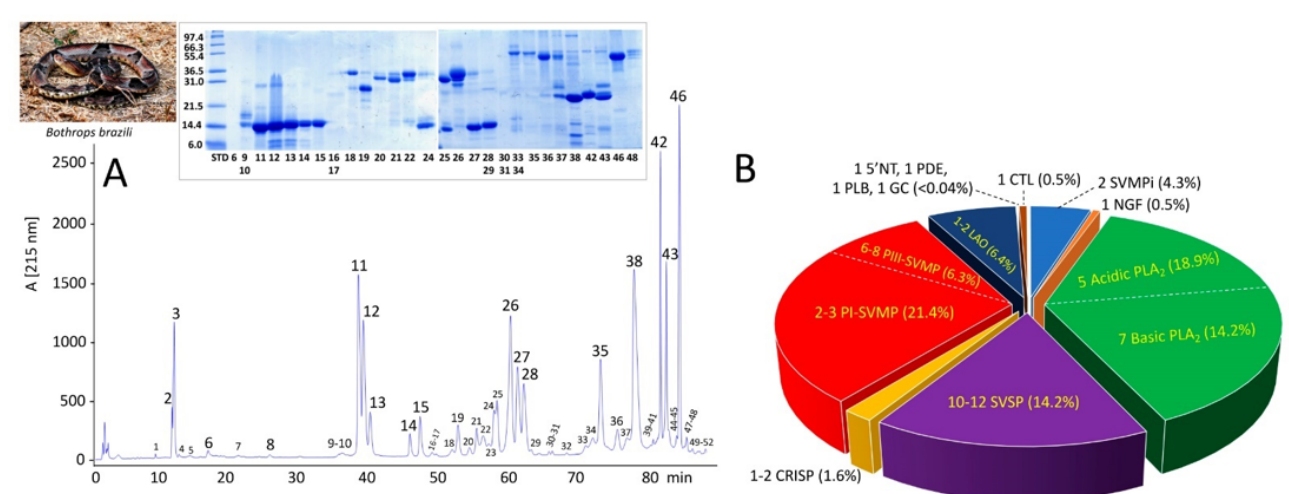
Figure 1. Venomics analysis of Bothrops brazili. (A) Reverse-phase chromatographic separation of the venom proteins of Bothrops brazili from Pará, Brazil. For venomics analysis the chromatographic fractions were collected manually and analyzed by SDS-PAGE (inset) under reduced conditions. Protein bands were excised, in-gel digested with trypsin, the resulting proteolytic peptides fragmented through LC-nESI-MS/MS, and the parent proteins identified by database searching and de novo sequencing followed by BLAST analysis (Additional file 1). The photograph of Bothrops brazili was kindly provided by Tiago Santana. (B) Pie chart displaying the estimated number and their relative occurrence (in percentage of total venom proteins) of toxins from the different protein families found in the venom proteome of Bothrops brazili (panel A ). SVMPi: tripeptide inhibitors of snake venom metalloproteinase (SVMP); NGF: nerve growth factor; PLA phospholipase A ; SVSP: snake venom serine protease; CRISP: cysteine-rich secretory protein; PI- and PIII-SVMP: SVMPs of class PI and PIII, respectively; LAO: 2 L-amino acid oxidase; 5’NT: 5’-nucleotidase; PDE: phosphodiesterase; PLB: phospholipase B; CTL: C-type